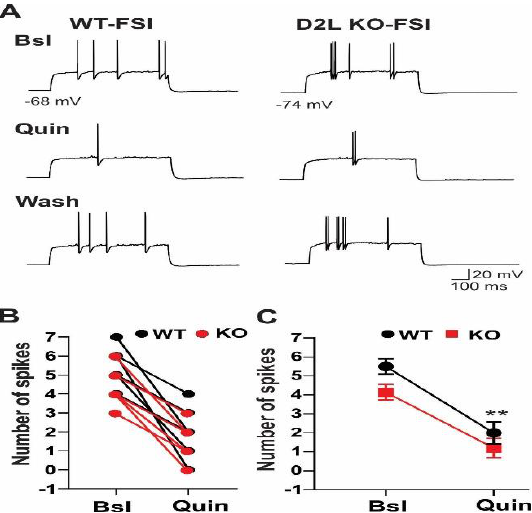
Figure 3. Effect of quinpirole on suppressing spike firing of FSIs was not altered in D2L KO mice. ( A ) Baseline (Bsl) spikes were induced by injecting depolarizing currents in MSNs from WT and D2L KO mice (top traces). The inhibitory effect of quinpirole (Quin) on the firing rate of FSIs was similar in WT (left middle trace) and D2L KO mice (right middle trace). Wash: spikes were recorded after washing off quin (bottom traces). ( B ) Summary of quinpirole effects on spike firing of FSIs from WT mice (filled black circles, n = 6) and from D2L KO mice (filled red circles, n = 8). The spike numbers of individual cells were plotted versus Bsl (without quin) or in the presence of Quin. ( C ) The mean spike numbers were plotted versus Bsl or Quin. ** p < 0.001 (WT); ** p < 0.001 (D2L